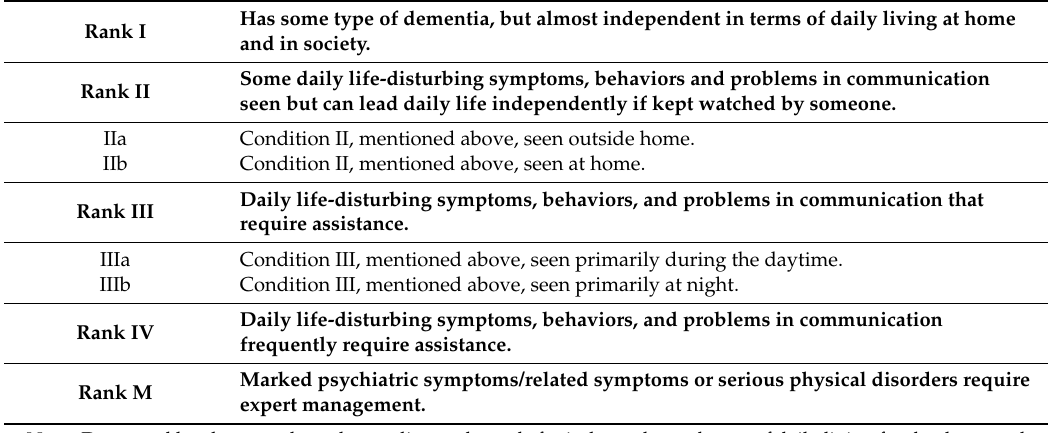
Table 2. Independence degree of daily living for the demented